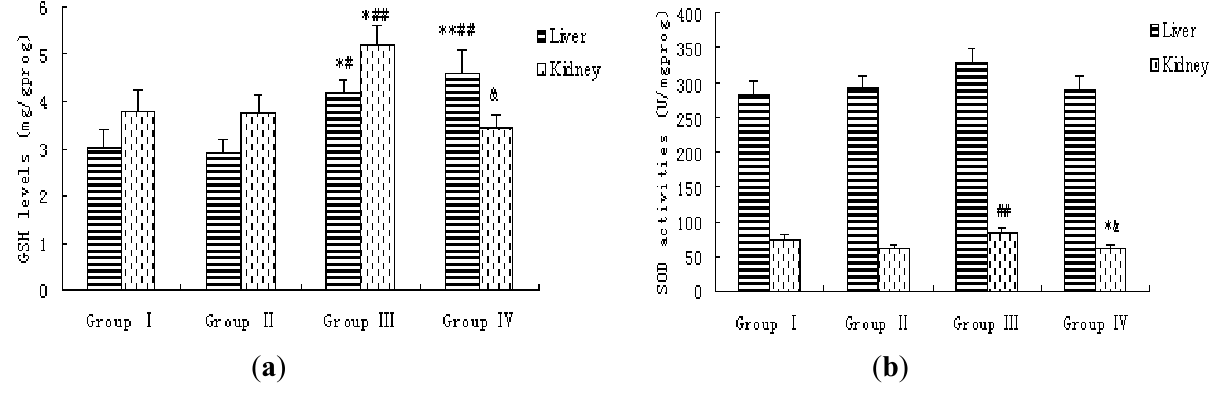
Figure 2. Lipid peroxidation levels and antioxidative status in liver and kidney of rats. ( a ) GSH levels; ( b ) SOD activities; ( c ) GSH-Px activities; ( d ) LPO production (MDA). Bars were presented as mean ±